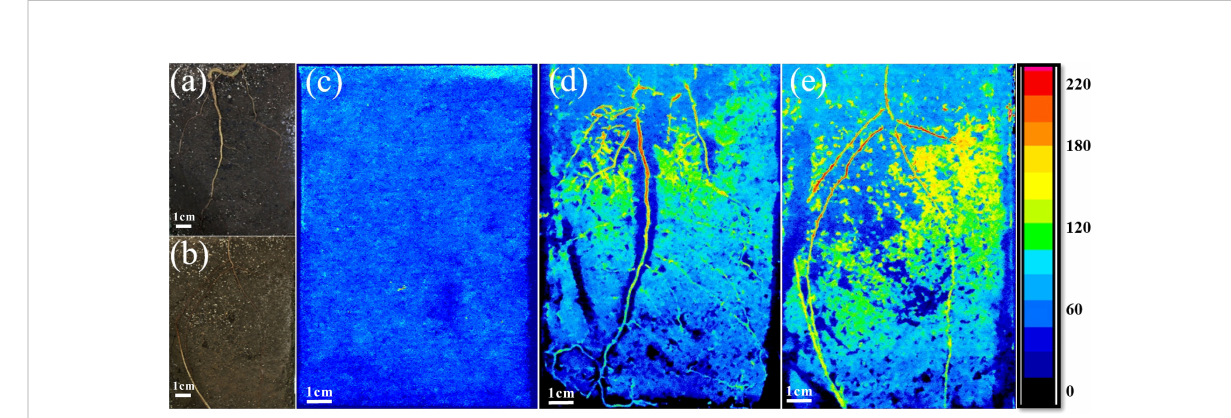
FIGURE 1 Roots of seedlings of European beech (A) and Norway spruce (B) grown in the rhizoboxes. Examples of zymographs showing the spatial distribution of acid phosphomonoesterase (AP) activity before planting (C) , and in the rhizosphere of European beech (D) and Norway spruce (E) . Side colour maps are proportional to the enzyme activities (pmol mm − 2 h − 1